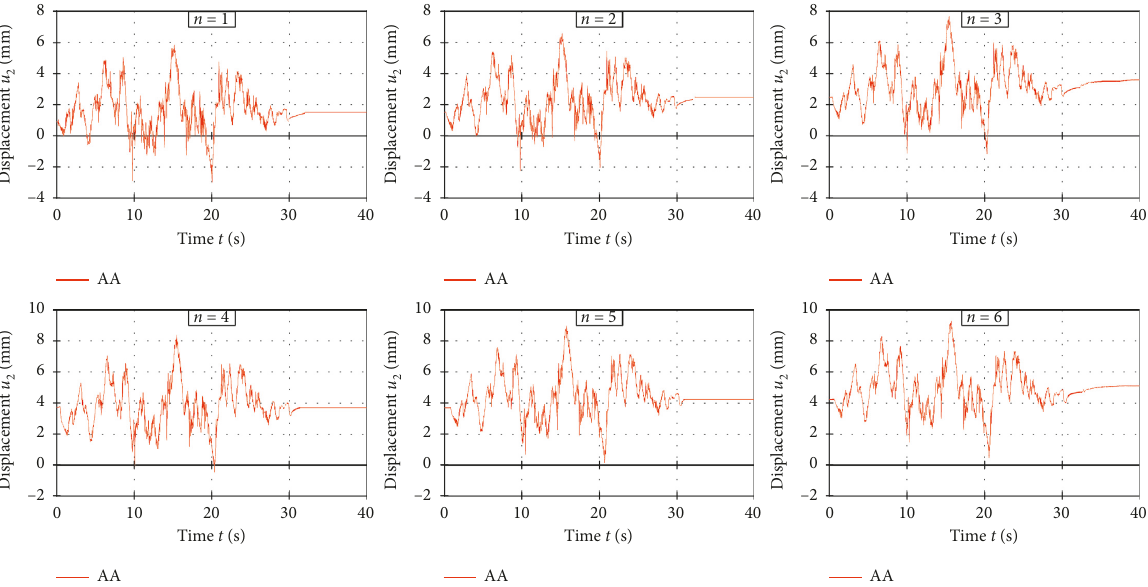
Figure 29: Horizontal displacement u